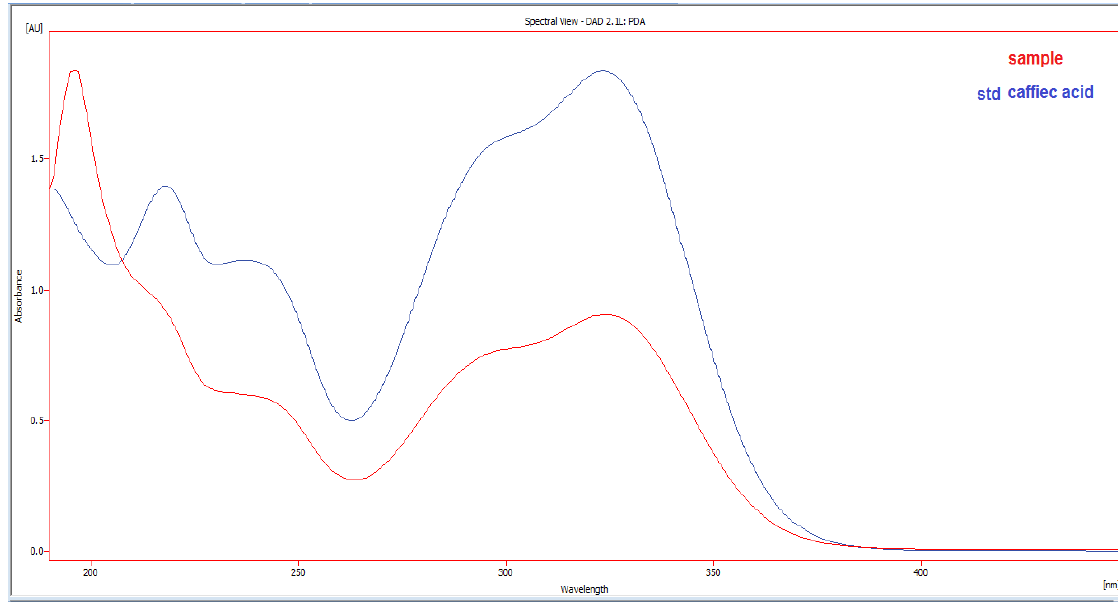
Figure 9. UV spectrum of ethyl acetate fraction matched with caffiec acid standard UV spectrum.